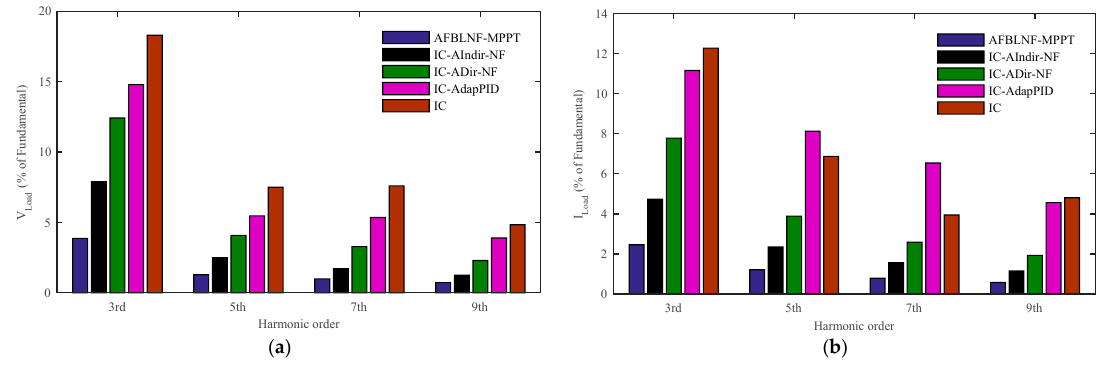
Figure 9. Harmonics of load ( a ) voltage ( b ) current.